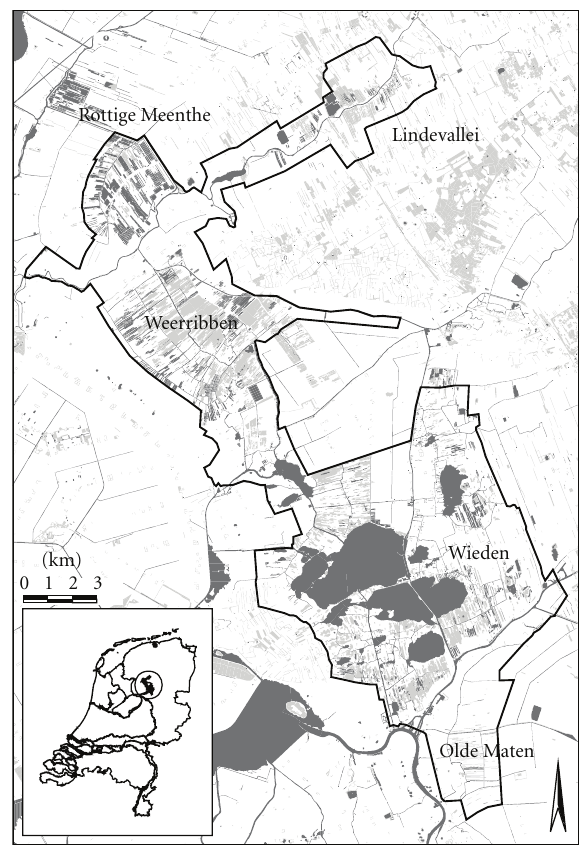
Figure 1: Geographical location of the study area. Within black borders the area where 31 otters (see Appendix A) were released between 2002 and 2008. The expanding population was monitored using telemetry and noninvasive genetic sampling.